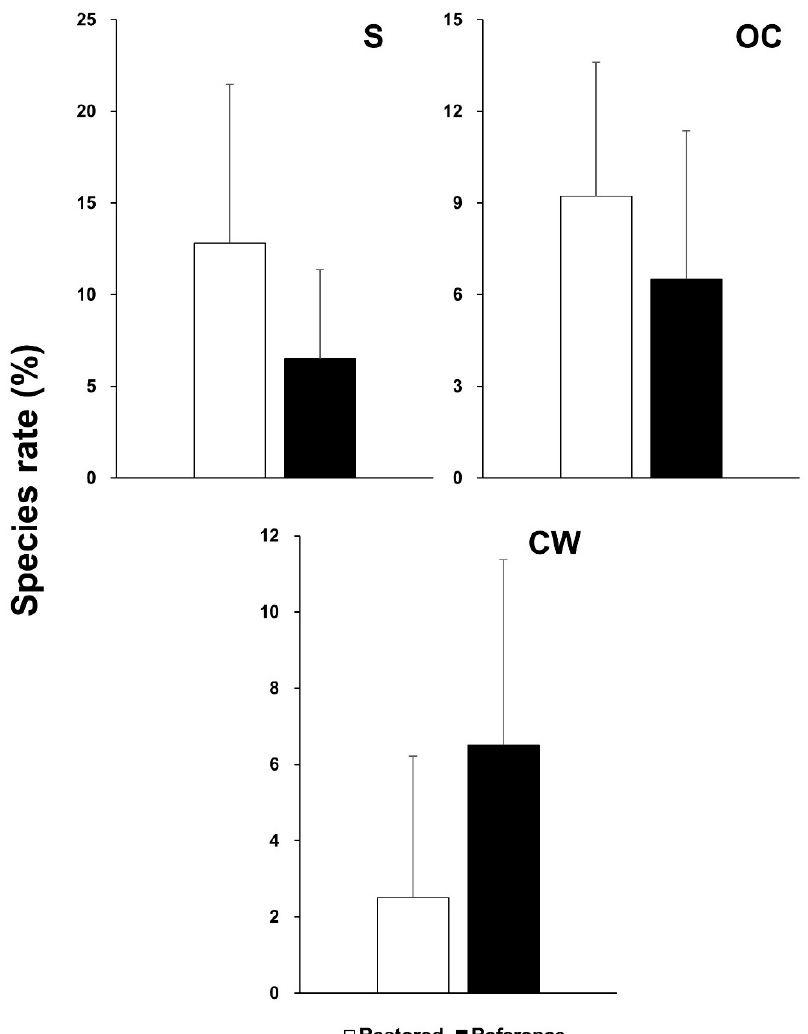
Figure 6. Comparisons of the percentage of exotic and gardening plants between the restored stream and the reference stream. The abbreviated stream name is the same as in Figure 2. Alpha- bet letters mean the result of the statistical test for the difference between the restored and the nat- ural reference streams. Different letters mean the significant difference and the same letter means no difference statistically. Exotic: exotic plant, Landscaping: plants introduced for landscaping.